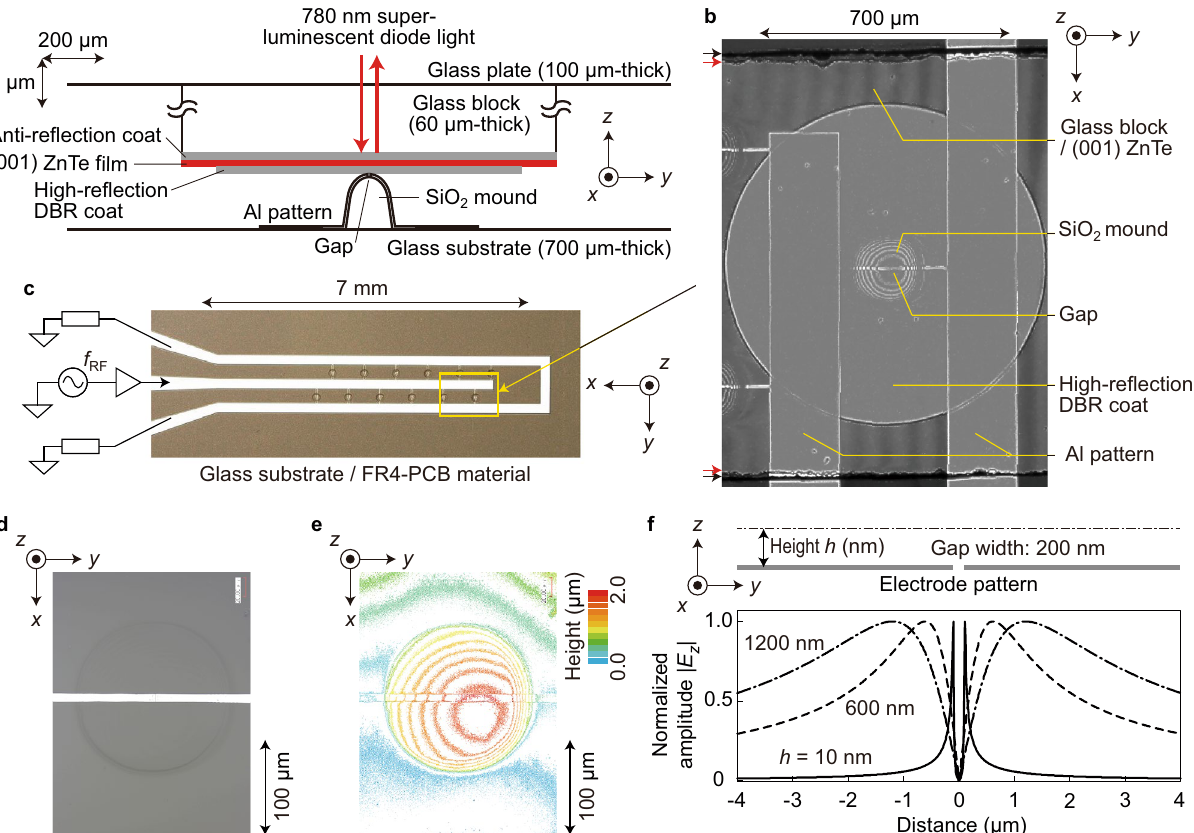
Figure 2. EO sensor on a nanometre-scale electrode pattern. ( a ) Cross-sectional schematic of a thin ZnTe film on a gap of an electrode pattern formed over a SiO 2 mound. Here, the anisotropic magnification ratio of the y- direction to the z -direction is 1:40. ( b ) Top-view photograph of the same setup taken at a low magnification. Red and black arrows indicate the edges of the glass block and ZnTe film, respectively. ( c ) Top-view photograph of an electrode pattern on a 700-μm-thick glass substrate adhered to an FR4 material. Additionally, external driving and termination circuits are schematically indicated. ( d ) Magnified optical image of one of the SiO 2 mounds taken by a confocal laser microscope without the EO sensor. ( e ) Three-dimensional structure of the mound in ( d ). ( f ) Theoretical model for calculation of the E z amplitude distribution above an electrode pattern with a 200-nm-wide gap along with the results calculated at three values of the height h . DBR: distributed Bragg